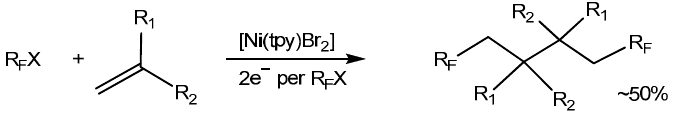
Figure 1. Cyclic voltammograms of [Ni(tpy)Br 2 ] (0.01 M) in the presence of increasing quantities of С 6 F 13 I. Ratios of complexes to R F I are 1:0 (red); 1:3 (blue); 1:6 (violet); 1:12 (dark blue); 1:30 (black). Reproduced from ref. [53] with permission form The Royal Society of Chemistry. The proposed mechanism of the process involves electrochemical reduction of the [Ni(II)(L)Br 2 ] complex to [Ni(I)(L)Br], followed by an oxidation by the fluoroorganic halide to regenerate [Ni(II)(L)BrX] (Scheme 20). The perfluoroalkyl radicals produced by these redox events react with α -